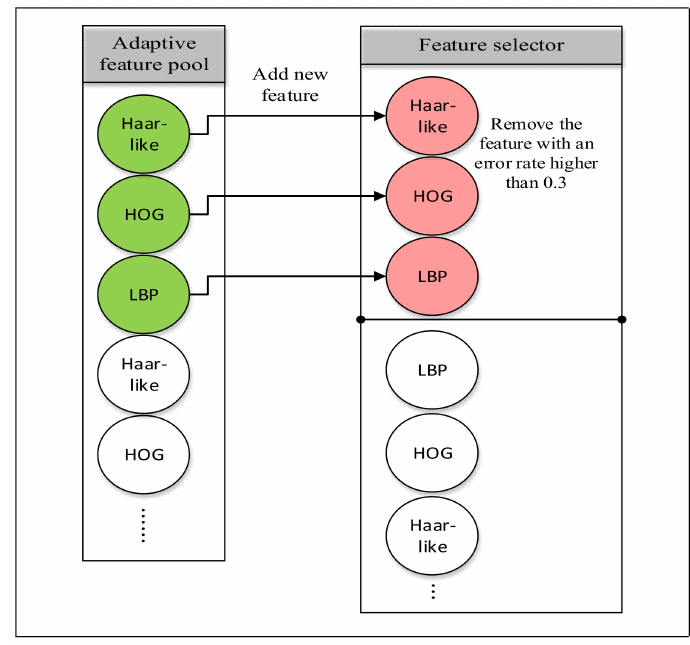
Figure 15. Updating method of the feature selector.